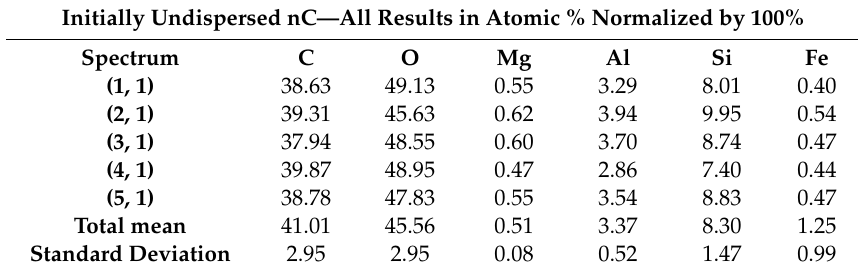
Table 3. Scanning electron microscopy / X-ray energy dispersive spectroscopy (SEM / EDX) counts summary (% atomic) of nC4.